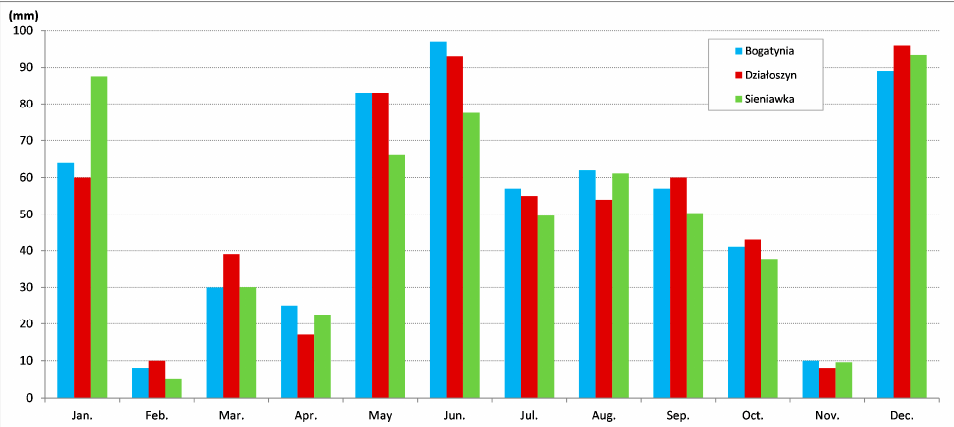
Figure 15. Monthly precipitation totals determined by the WRF/CALMET model in selected towns in 2018 (source: own study).